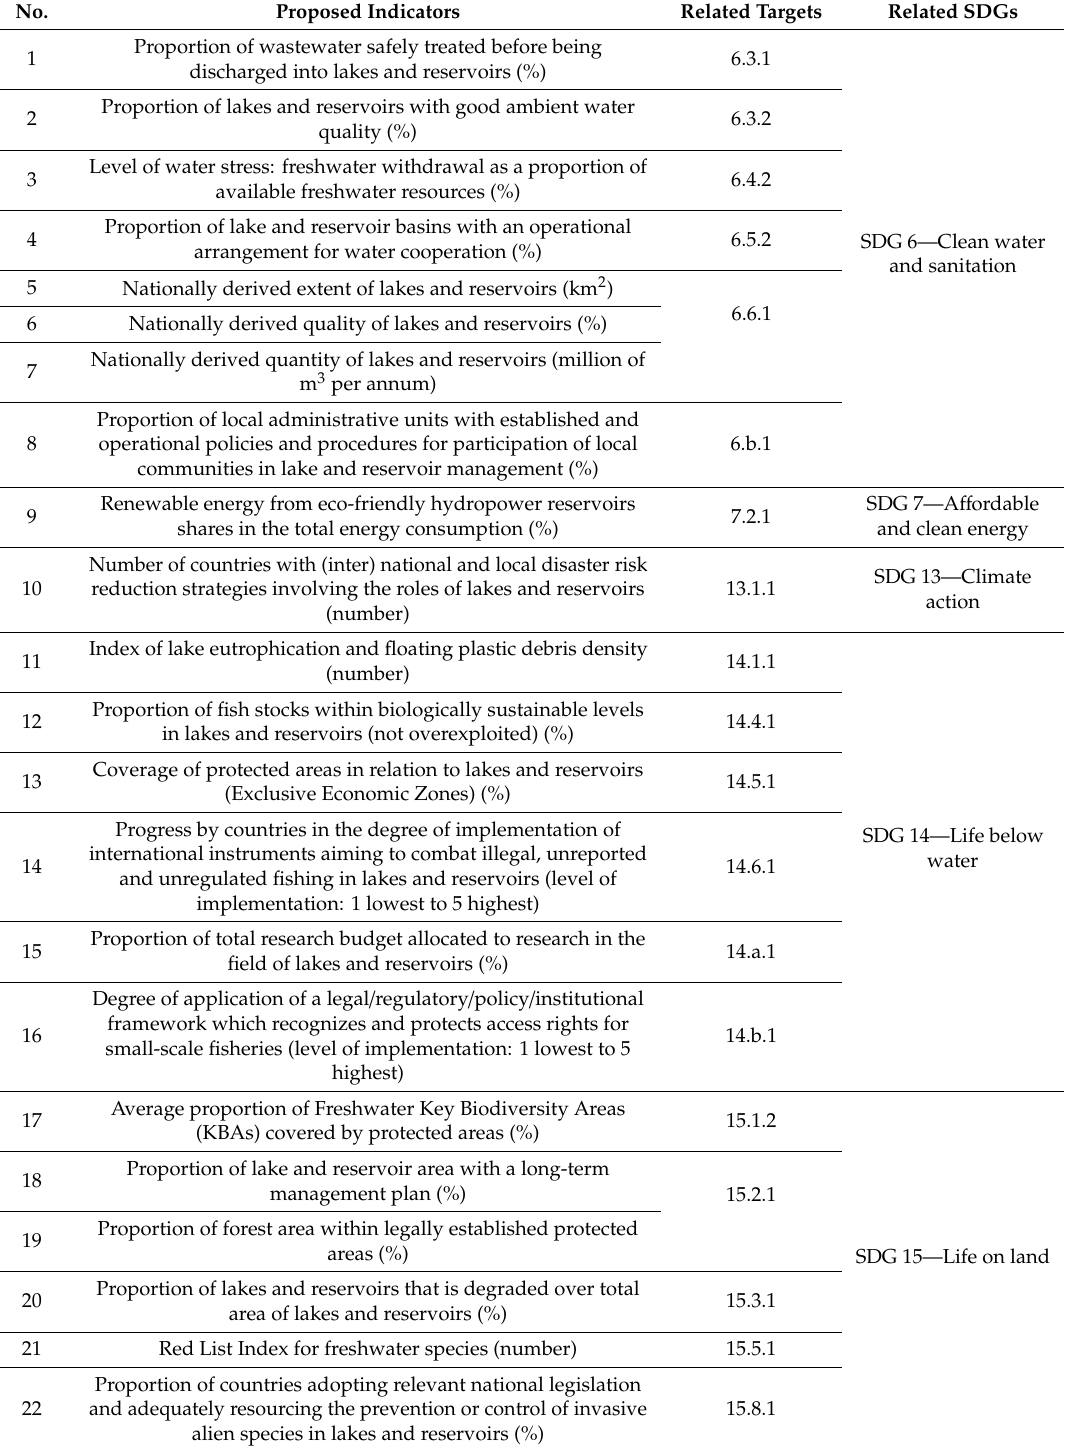
Table 2. Proposed indicators for monitoring the sustainable development of lakes and